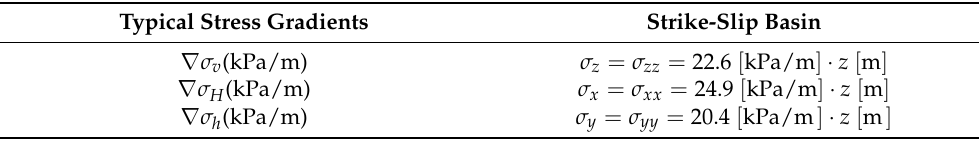
Figure 5. Coordinate system used for the stress analysis in the matrix rock near three pressure-loaded hydraulic fractures (not to scale). Apertures of the hydraulic fractures in this conceptual drawing are vastly exaggerated; in reality, fracture walls are about 2–3 cm apart during the pressure-loading phase of the fracture treatment. Table 2. Conversion of principal stresses to stress tensor